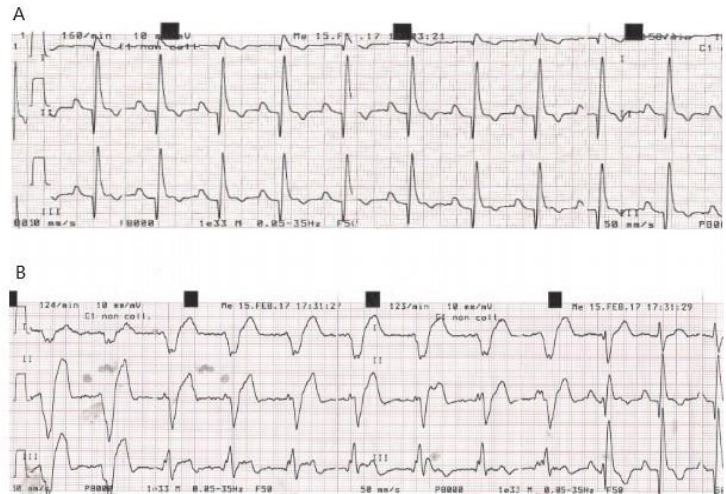
Figure 1. Dog C4 (Great Dane M, 6.5 years old). ( A ) ECG recorded at D0 before gene delivery procedure showing a sinus rhythm. ( B ) ECG recorded at 5 h post procedure.